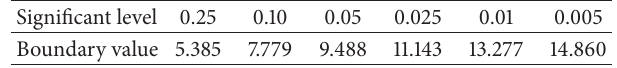
Table 2: Significant levels and related boundary